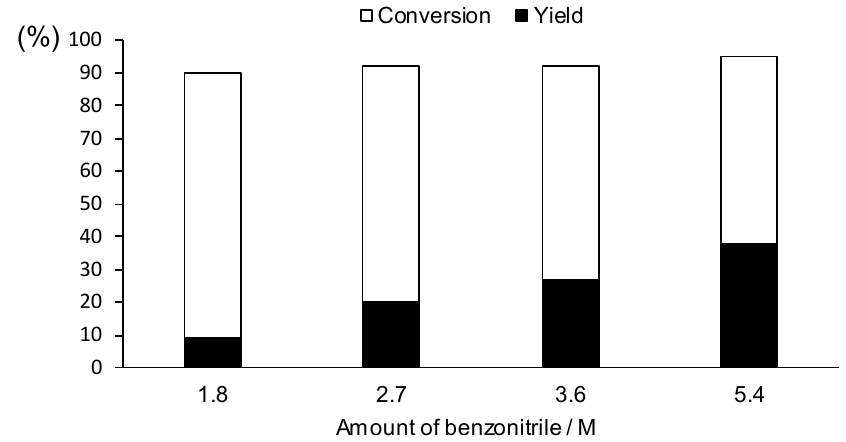
Figure 3. Effect of the benzonitrile ( 2a ) concentration on the yield of 3a and conversion of 1a .